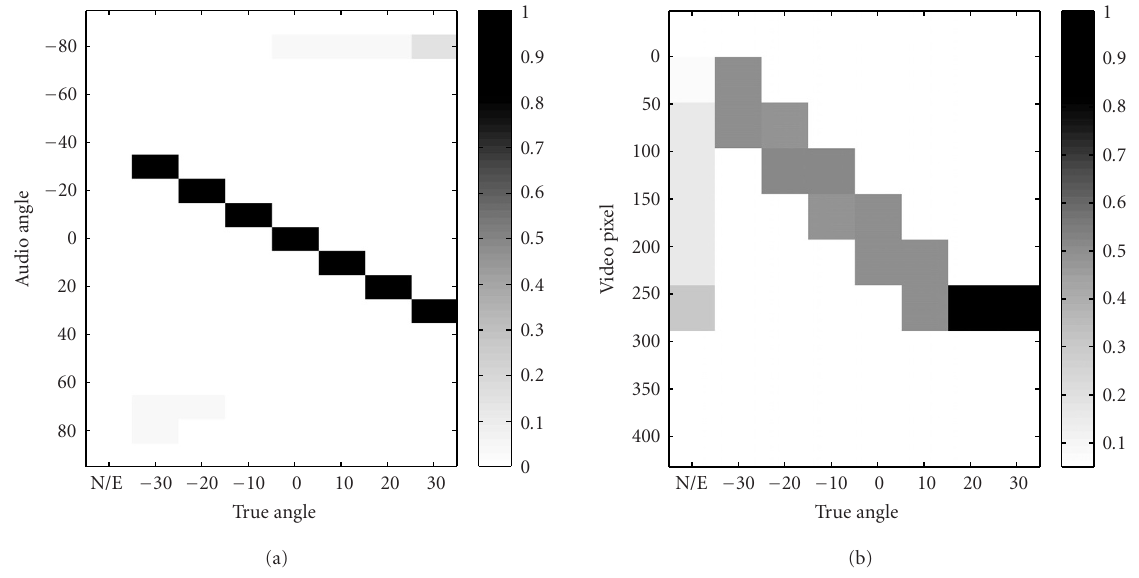
Figure 6: CPTs obtained from the training samples. “N/E” indicates the state “NoEvent.” (a) CPT for audio; (b) CPT for video.